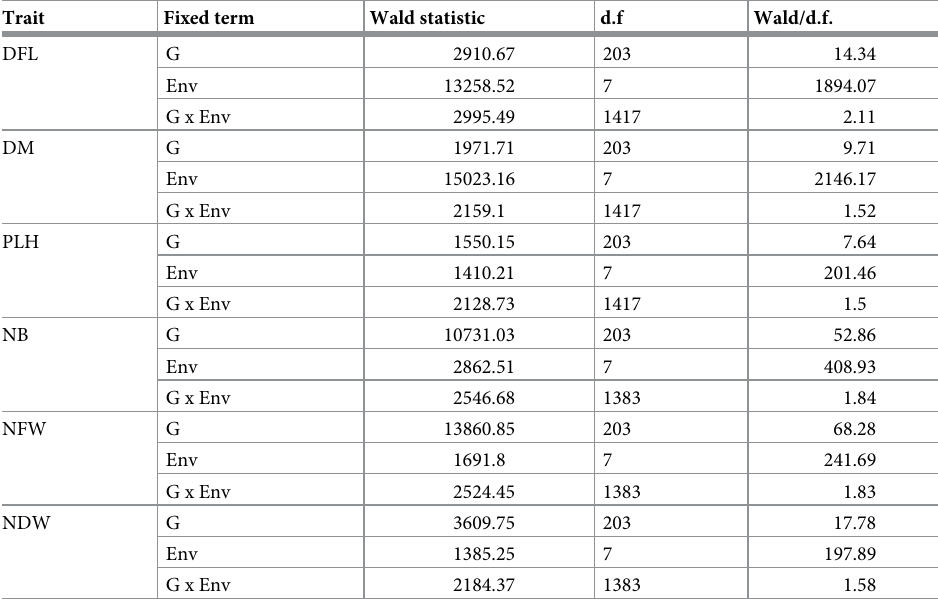
Table 1. Components of variance of morphological traits of 204 genotype in the field experiment at two locations during 2016 and 2017 post rainy seasons (Chi-sq. probability < 0.001). Degree of freedom (d.f.).